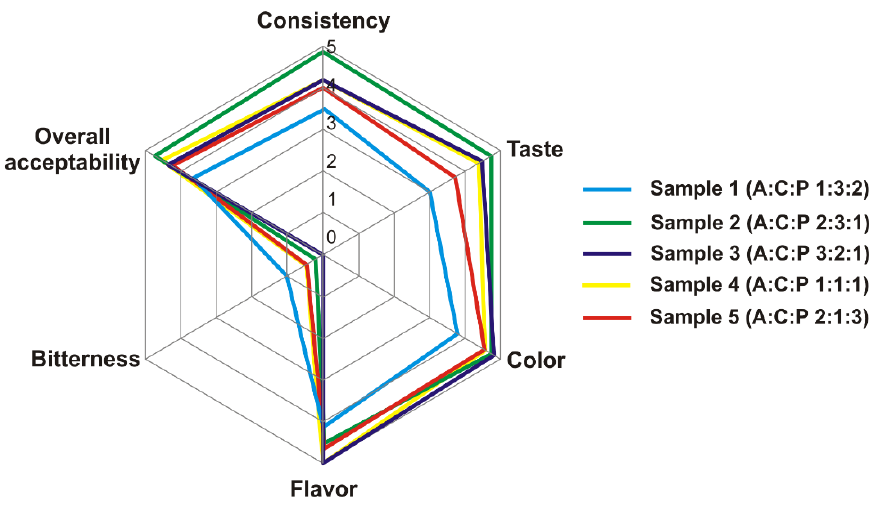
Figure 3. The organoleptic properties of WPH–PS compositions.